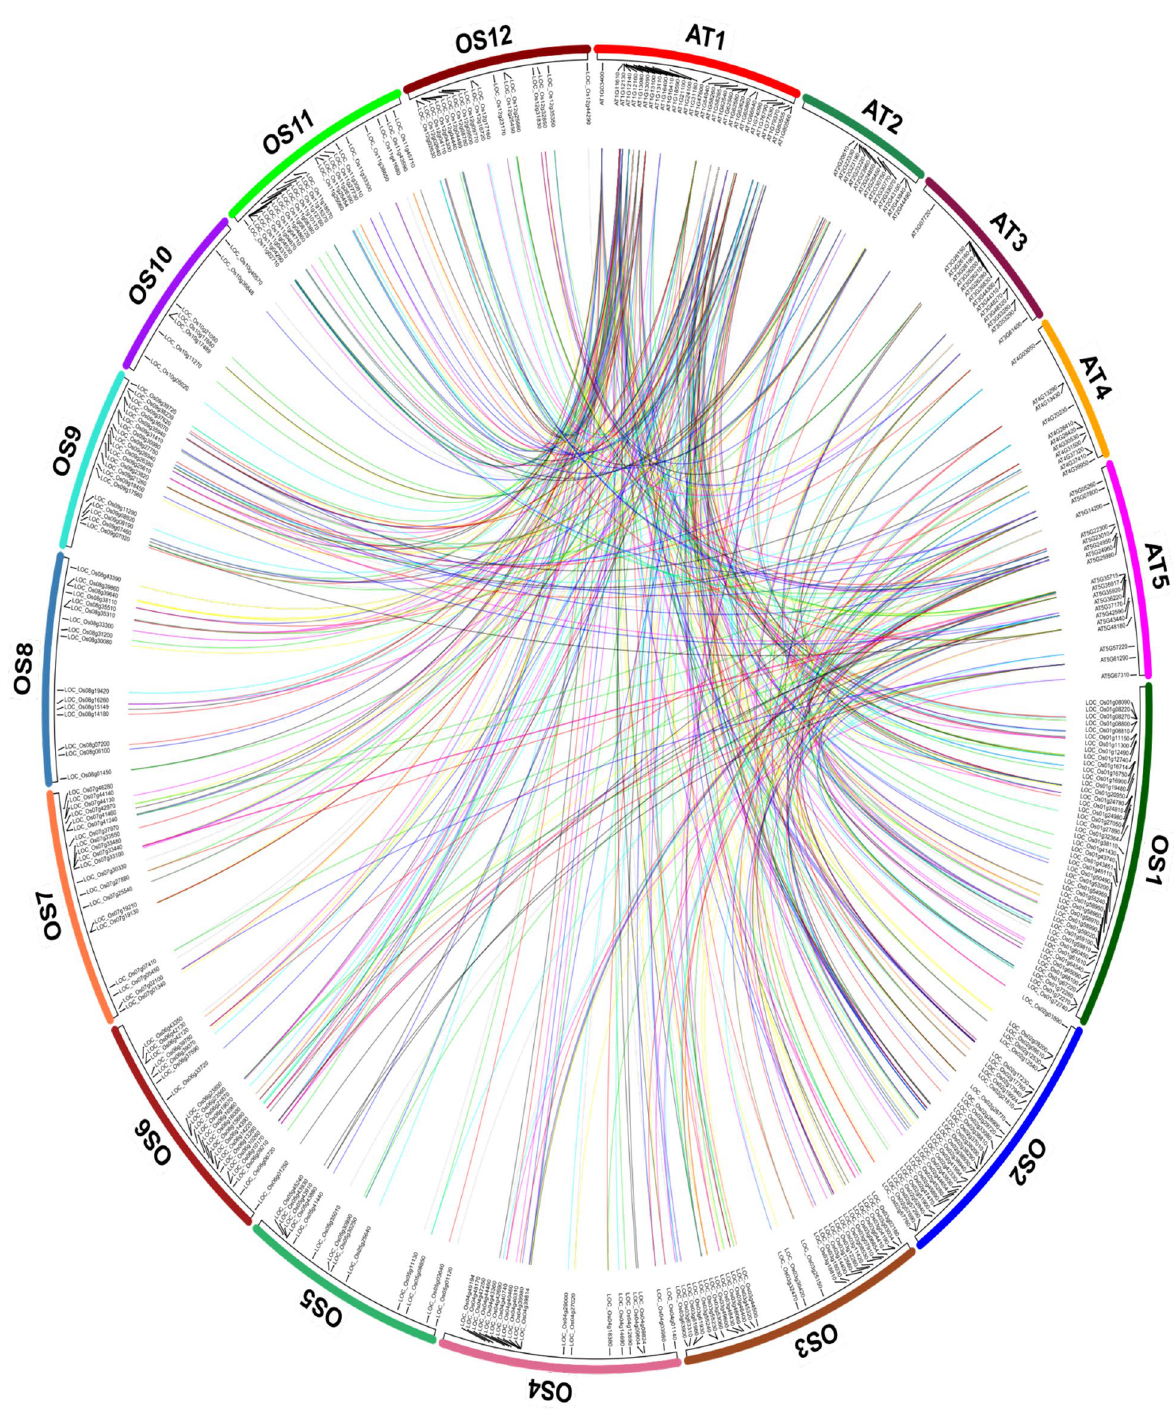
Figure 1. The Arabidopsis thaliana (At)- Oryza sativa (Os) sulfur-containing compound (SCC) encoding biosynthetic synteny gene pairs identified with MCScanX. There are 477 syntenic gene pairs (represented by connecting colour lines) between 89 AtSCC and 265 OsSCC biosynthetic genes. The numbering on AT and OS labels denotes the chromosome